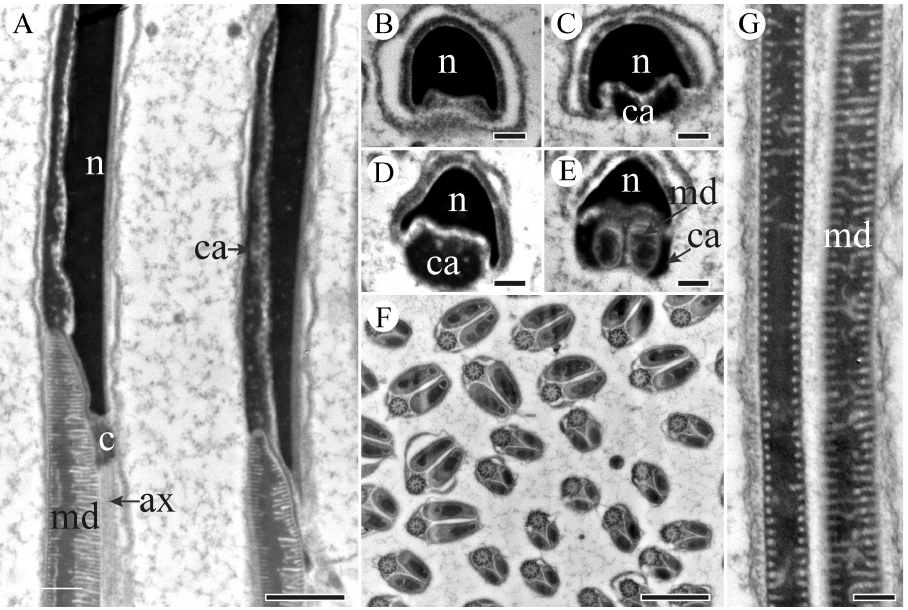
Figure 6. TEM sections through the neck and tail regions of the spermatozoa of K. caelatata . A Lon- gitudinal section through the neck region showing nucleus (n), centriolar adjunct (ca), centriole (c), axoneme (ax) and mitochondrial derivatives (md) B Cross-section through the mid-neck region, showing one side of the nucleus forms two ridges. C and D Cross-sections through the posterior part of nucleus, showing centriolar adjunct (ca) flanked nucleus (n) E Cross-section of the base of the nucleus, showing triangular nucleus (n) and two mitochondrial derivatives (md) embedded into the material of the centri- olar adjuncts (ca) F Cross-section through sperm tails, showing mitochondrial derivatives with distinct diameters G Longitudinal section of sperm tail, showing paired mitochondrial derivatives (md). Scale bars: 1 μm ( A, F ), 200 nm ( B–E, G